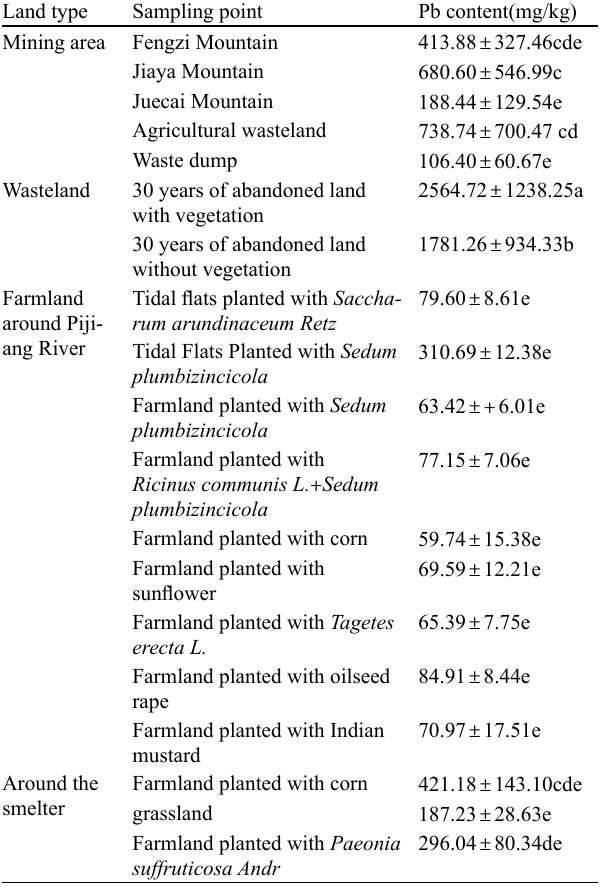
Table 1 The content of heavy metal Pb in the soil of different areas of Jinding mining area in Lanping county (Modified after He et al.